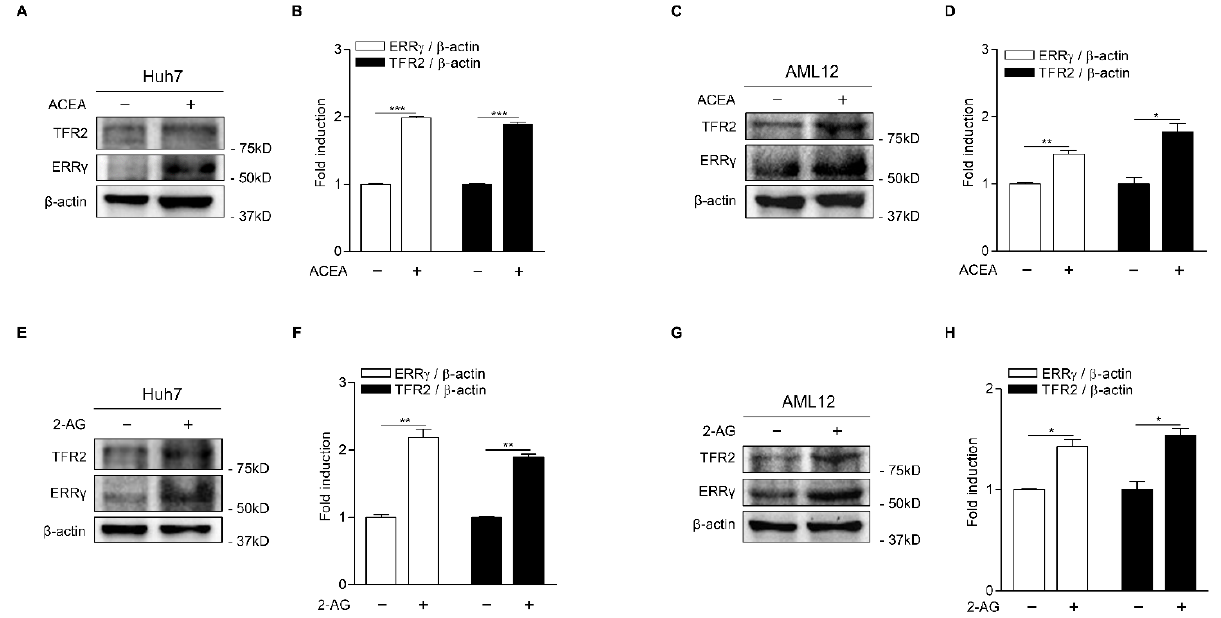
Figure 2. CB1 receptor signaling induces ERR γ and TFR2 protein expression. ( A – D ) Western blot analysis ( A , C ) and graphical representation ( B , D ) showing ERR γ and TFR2 protein levels. Huh7 cells ( A ) and AML12 cells ( C ) were treated with ACEA (10 µ M) for 12 h. ( E – H ) Western blot analysis ( E , G ) and graphical representation ( F , H ) showing ERR γ and TFR2 protein levels. Huh7 cells ( E ) and AML12 cells ( G ) were treated with 2-AG (10 µ M) for 12 h. The independent experiments were repeated at least twice. Error bars show ± SD. * p < 0.05, ** p < 0.01, *** p < 0.001 by two-tailed Student’s t test.